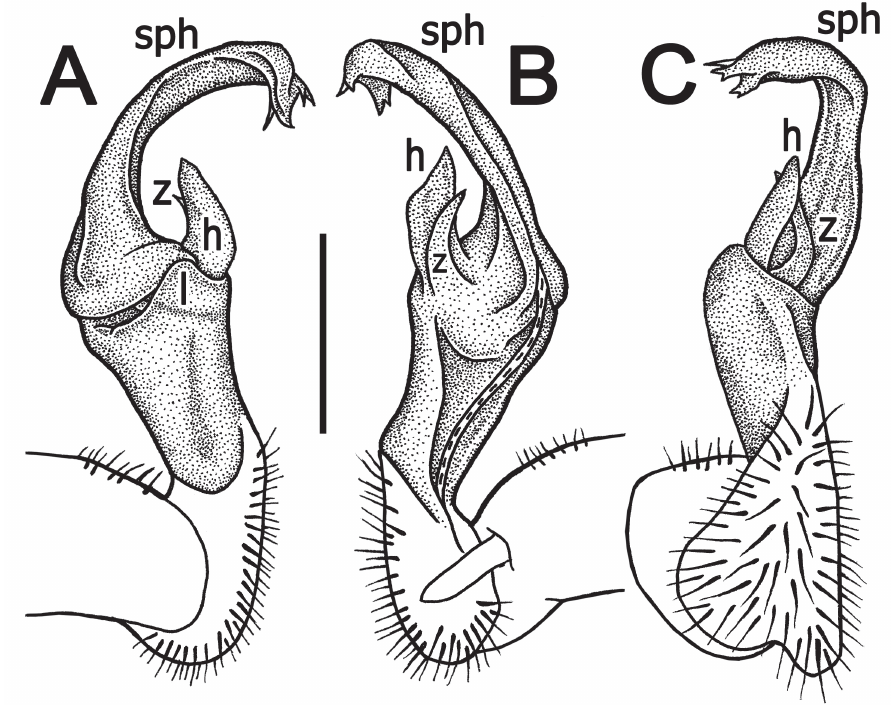
Fig. 5. Tylopus hongkhraiensis sp. nov., holotype, ♂, right gonopod. A–C . Lateral, mesal and suboral views, respectively. Scale bar = 0.2 mm. abbreviations are explained in the